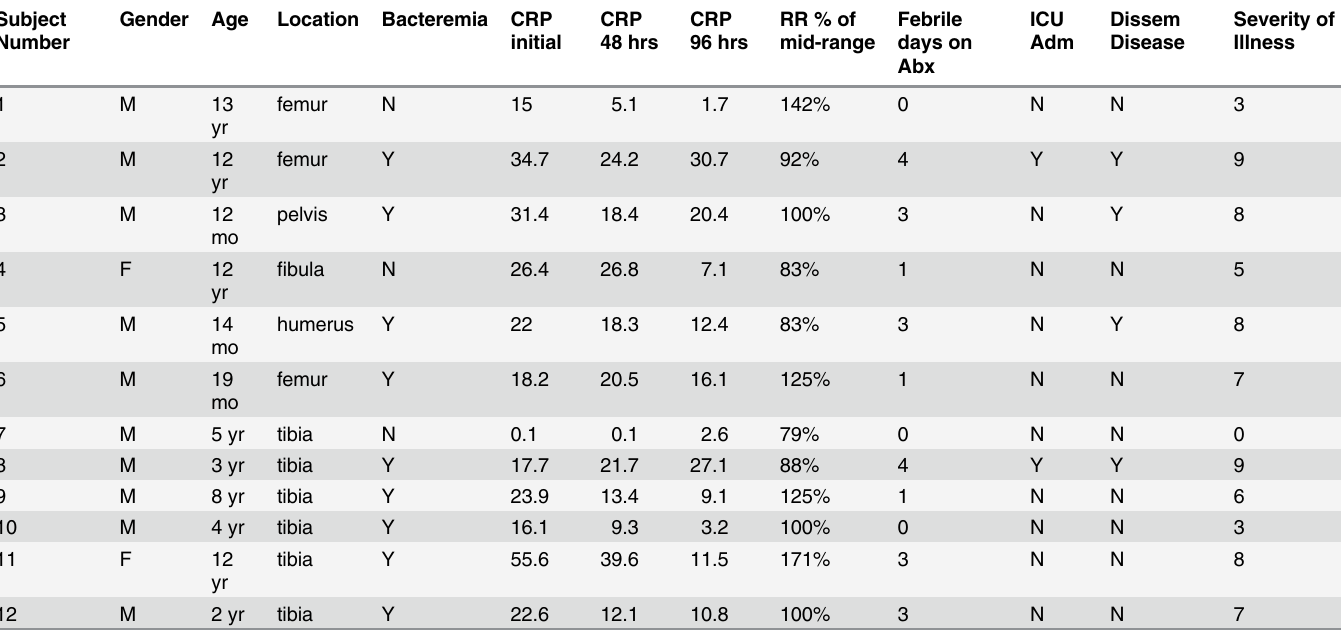
Table 1. Clinical and Laboratory Features Determining Severity of Illness Score of Children with Acute Hematogenous Osteomyelitis. Subject Gender Number